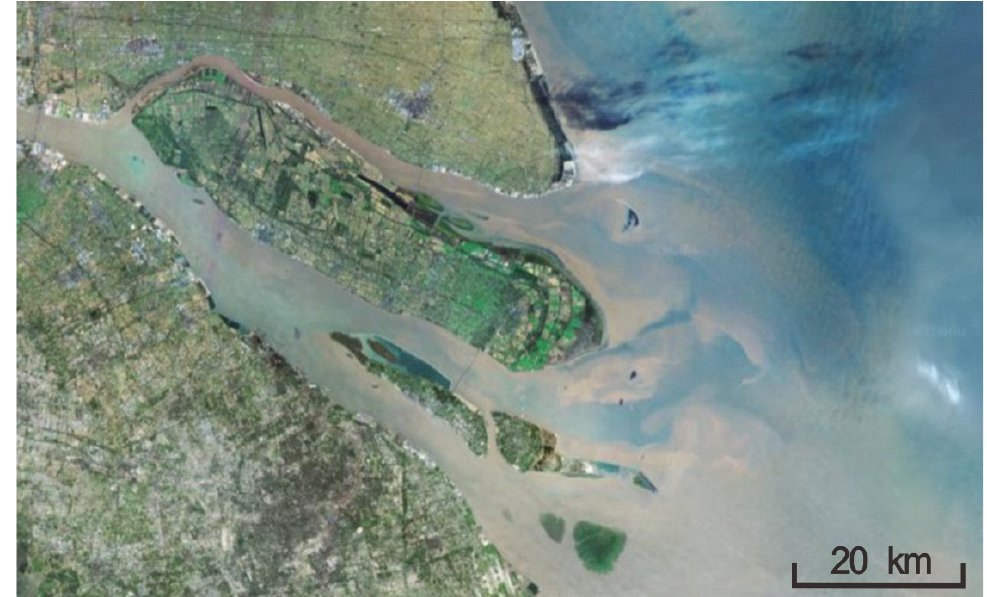
Figure 4. Location of modern sandbars for distant measurement.